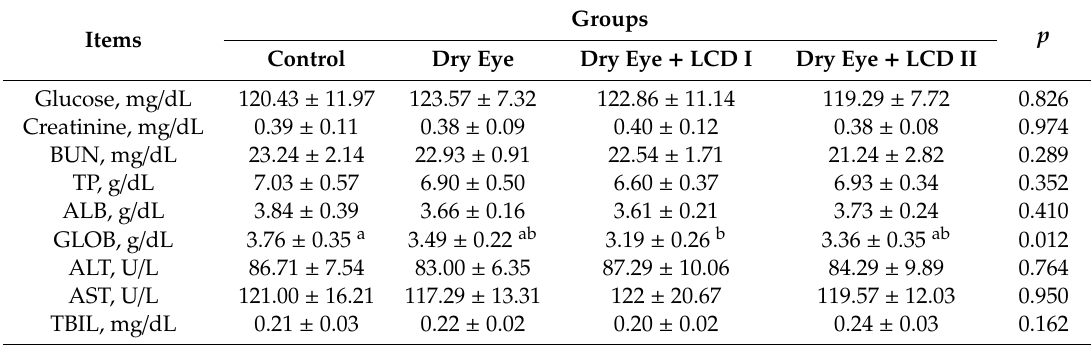
Table 2. E ff ect of the combination of lutein / zeaxanthin, curcumin, and vitamin D (LCD) on